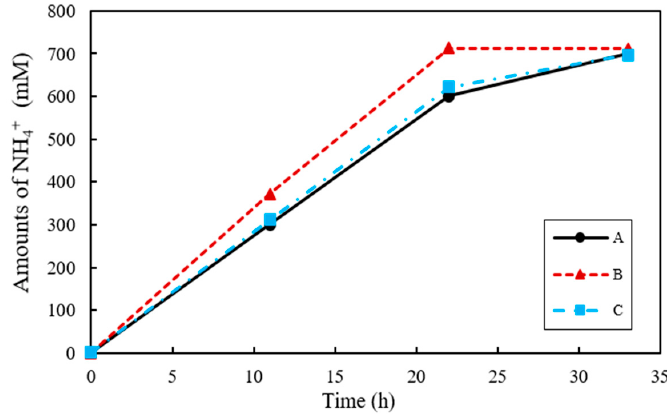
Figure 3. The changes of dissolved NH 4+ concentration in urea–calcium lactate medium over time.